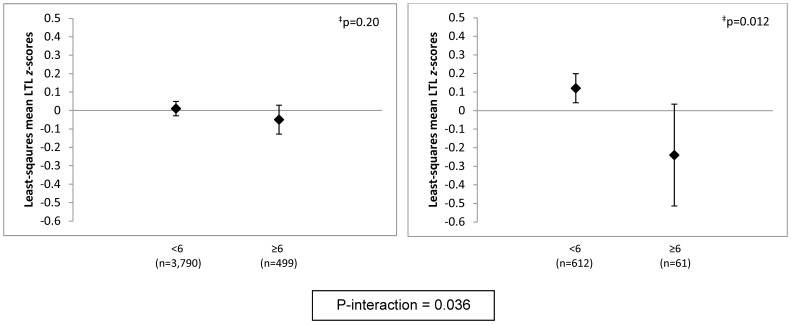
Adjusted* least-squares mean telomere length z-scores, by phobic anxiety level, stratified by paternal age (<40 or ≥40 years).*, Models were adjusted for age in years (continuous), pack-years of smoking (0, >0 to <20, 20 to <40, ≥40), body mass index (continuous, kg/m2) and physical activity (continuous, MET-hrs/wk). Least squares means and 95% confidence intervals are shown. N = 281 excluded due to missing paternal age. ‡, P-value for test of difference in least-squares means.